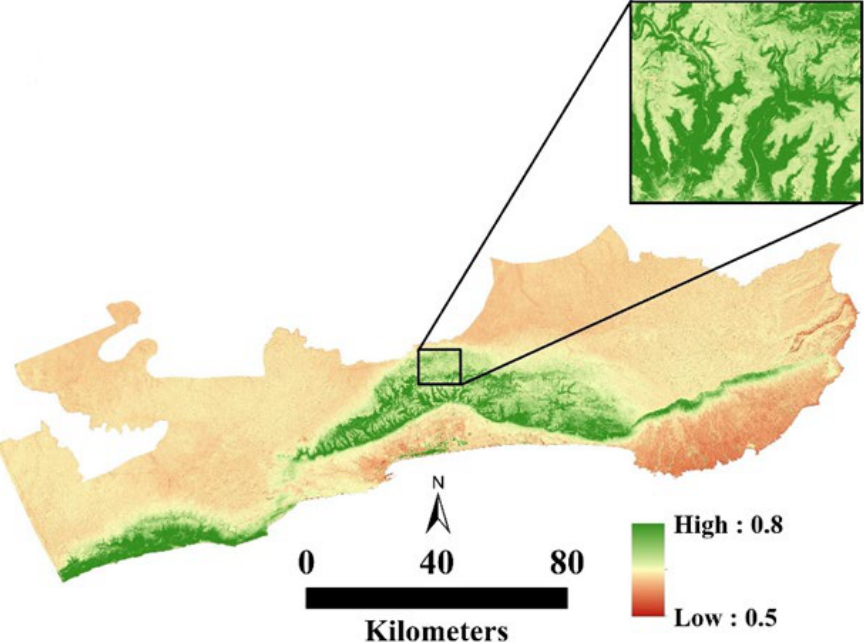
Figure 4. The spatial distribution of NDVI values for October 2015; the small box indicates the contrast between forests (dark green) and grasslands (light green).